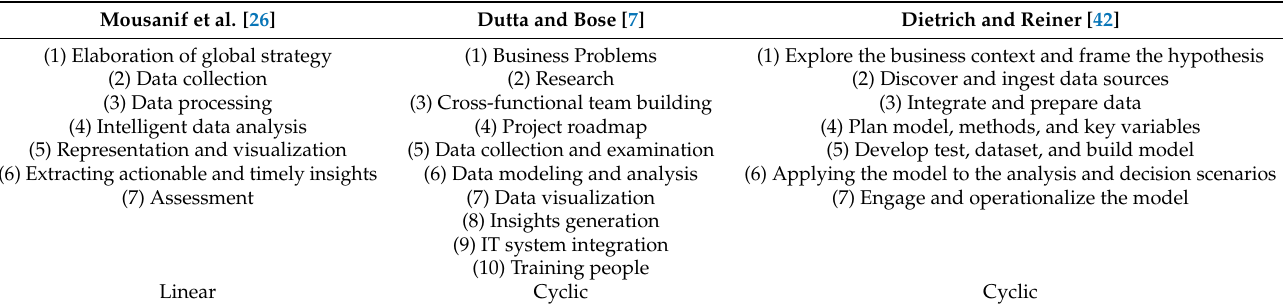
Table 5. Big Data Project